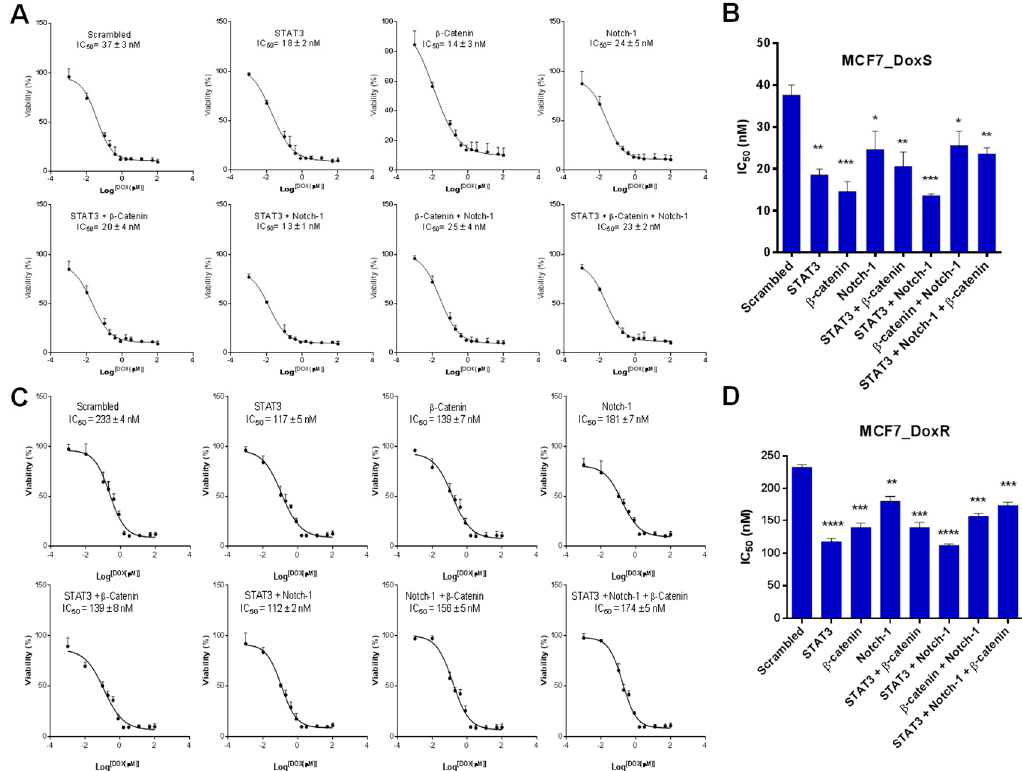
Figure 7. IC 50 values after siRNA and doxorubicin treatment. Both MCF7_DoxS and MCF7_DoxR cells were treated with a fixed concentration of siRNA (50 nM) and different concentrations of doxorubicin for 72 h to assess the effect of siRNA and doxorubicin combinations on cell viability using the MTT assay. ( A ) The dose–response curves and ( B ) the IC 50 values of doxorubicin combined with single and combinations of siRNA in MCF7_DoxS. ( C ) The dose–response curves and ( D ) the IC 50 values of doxorubicin combined with single and combinations of siRNA in MCF7_DoxR. Scrambled siRNA was used as the negative control for comparison. All IC 50 values represent the average of three independent experiments with four replicates per siRNA concentration for each experiment. Statistical